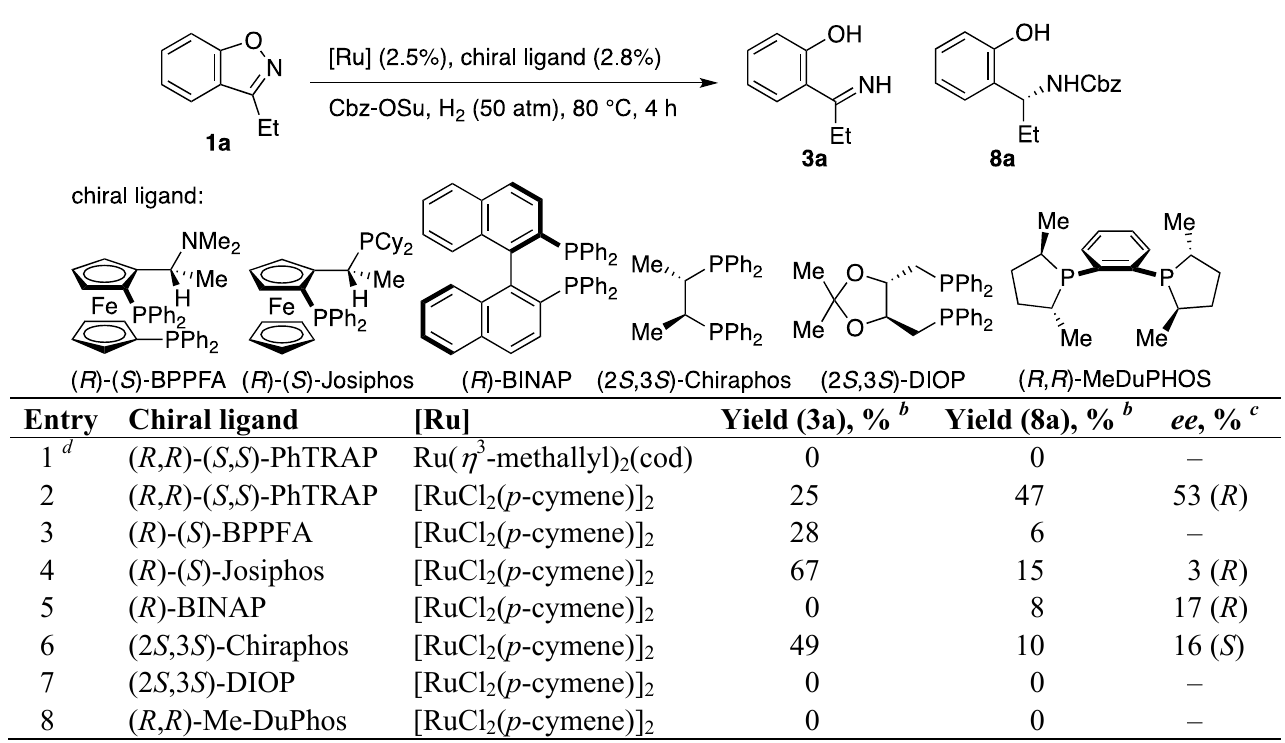
Table 2. Effect of chiral catalysts on the hydrogenation of 1a a